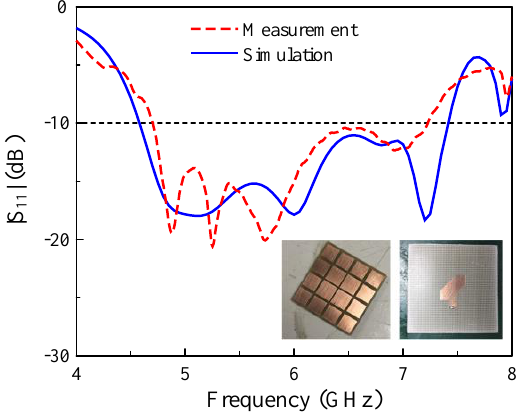
Figure 9. Simulated and measured | S 11 | of the proposed antenna.